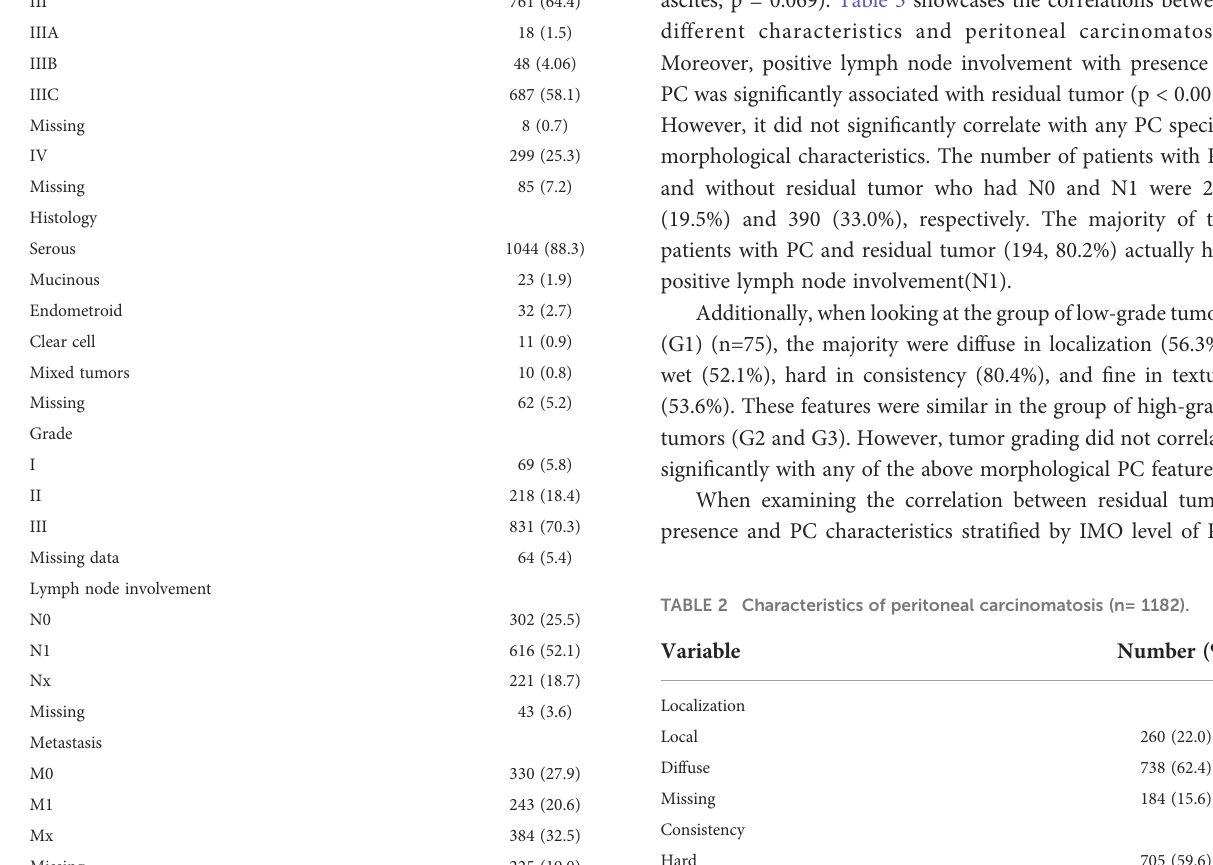
FIGO, International Federation of Gynaecology and Obstetrics. *Interquartile range